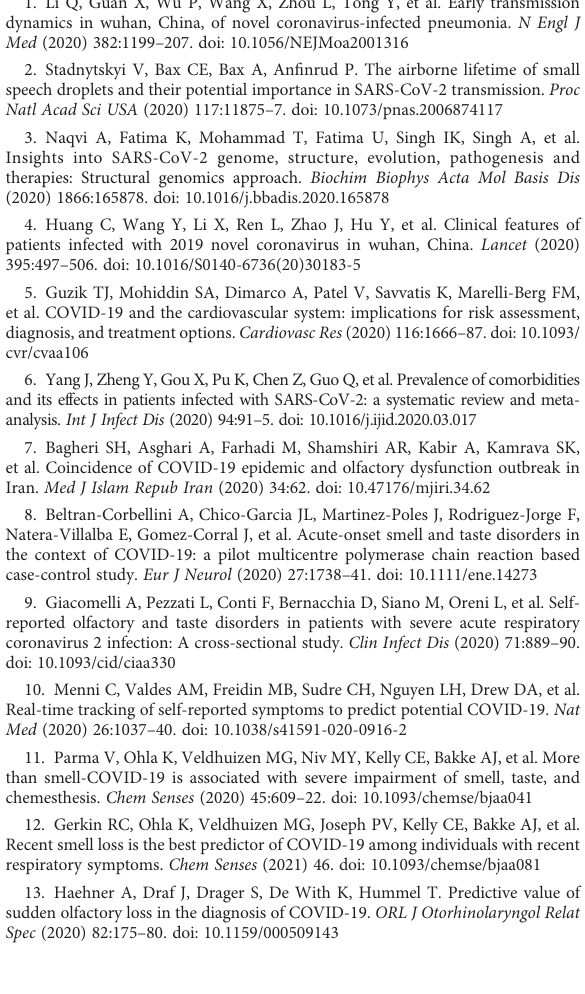
Functional analysis of DEPs exclusively modulated by a SARS-CoV-2 structural protein.